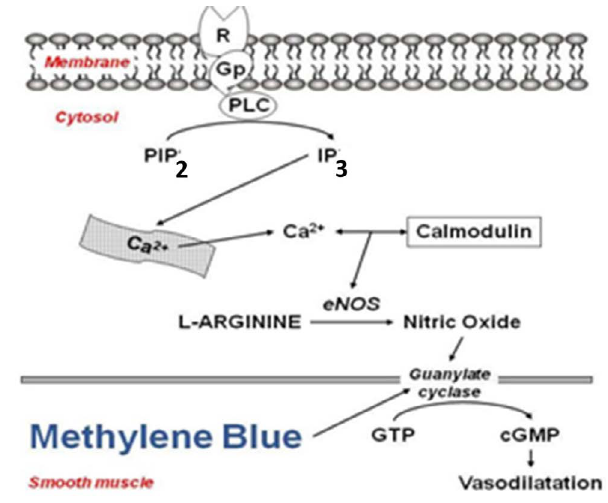
Fig. 1 - The classical endothelial nitric oxide (NO) release pathway requires 1) signal transduction from a cell receptor-mediated by G proteins (Gp); 2) phospholipase C (PLC) activation and production of inositol triphosphate (IP3) from phosphatidylinositol 4,5-biphosphate (PIP2) and cytosolic Ca2+ release; 3) the constitutive endothelial NO synthase (eNOS) is activated by complex Ca2+/calmodulin and produces NO from its substrate L-arginine; 4) NO stimulates guanylate cyclase in adjacent smooth muscle cells, which causes an increase in cyclic guanosine monophosphate (cGMP) that is the final stimulus that causes vasorelaxation; and 5) methylene blue inhibits the activity of guanylate cyclase, decreasing the cGMP production and less vascular smooth muscle relaxation (adapted from Evora et al., 2009[1]).